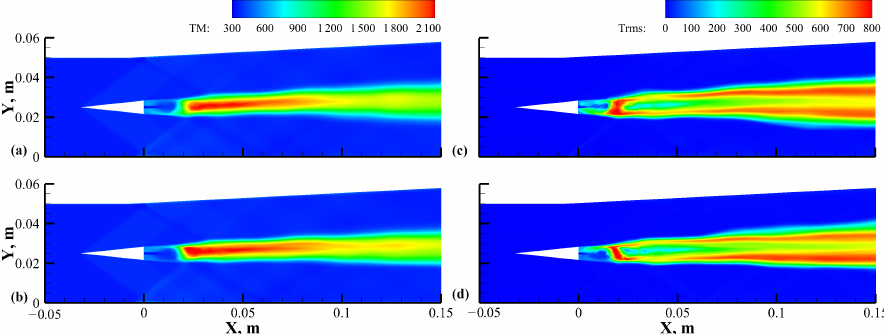
Figure 23. Contours of time-averaging temperature using the PaSR and PaSR-ISCM combustion models for ( a ) M0 and ( b ) M2; and rms fluctuation of temperature from the results of ( c ) M0 and ( d )